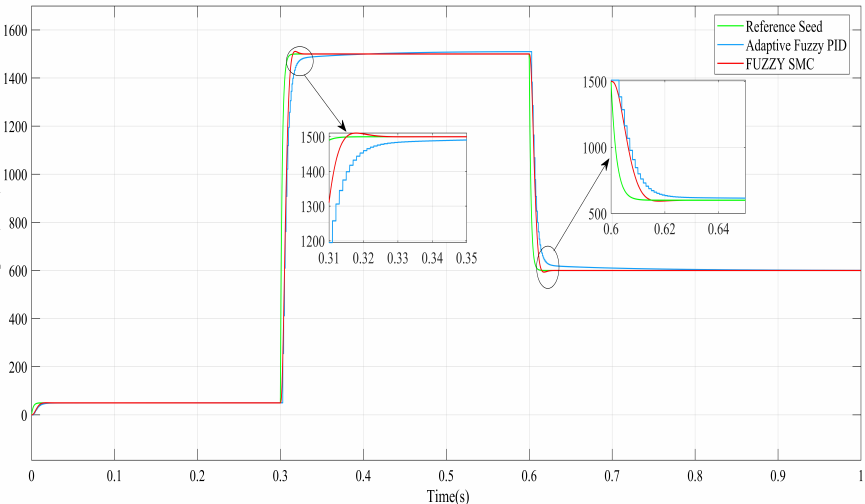
Figure 8. Measured speed response to step change with reference speed when speed increased.